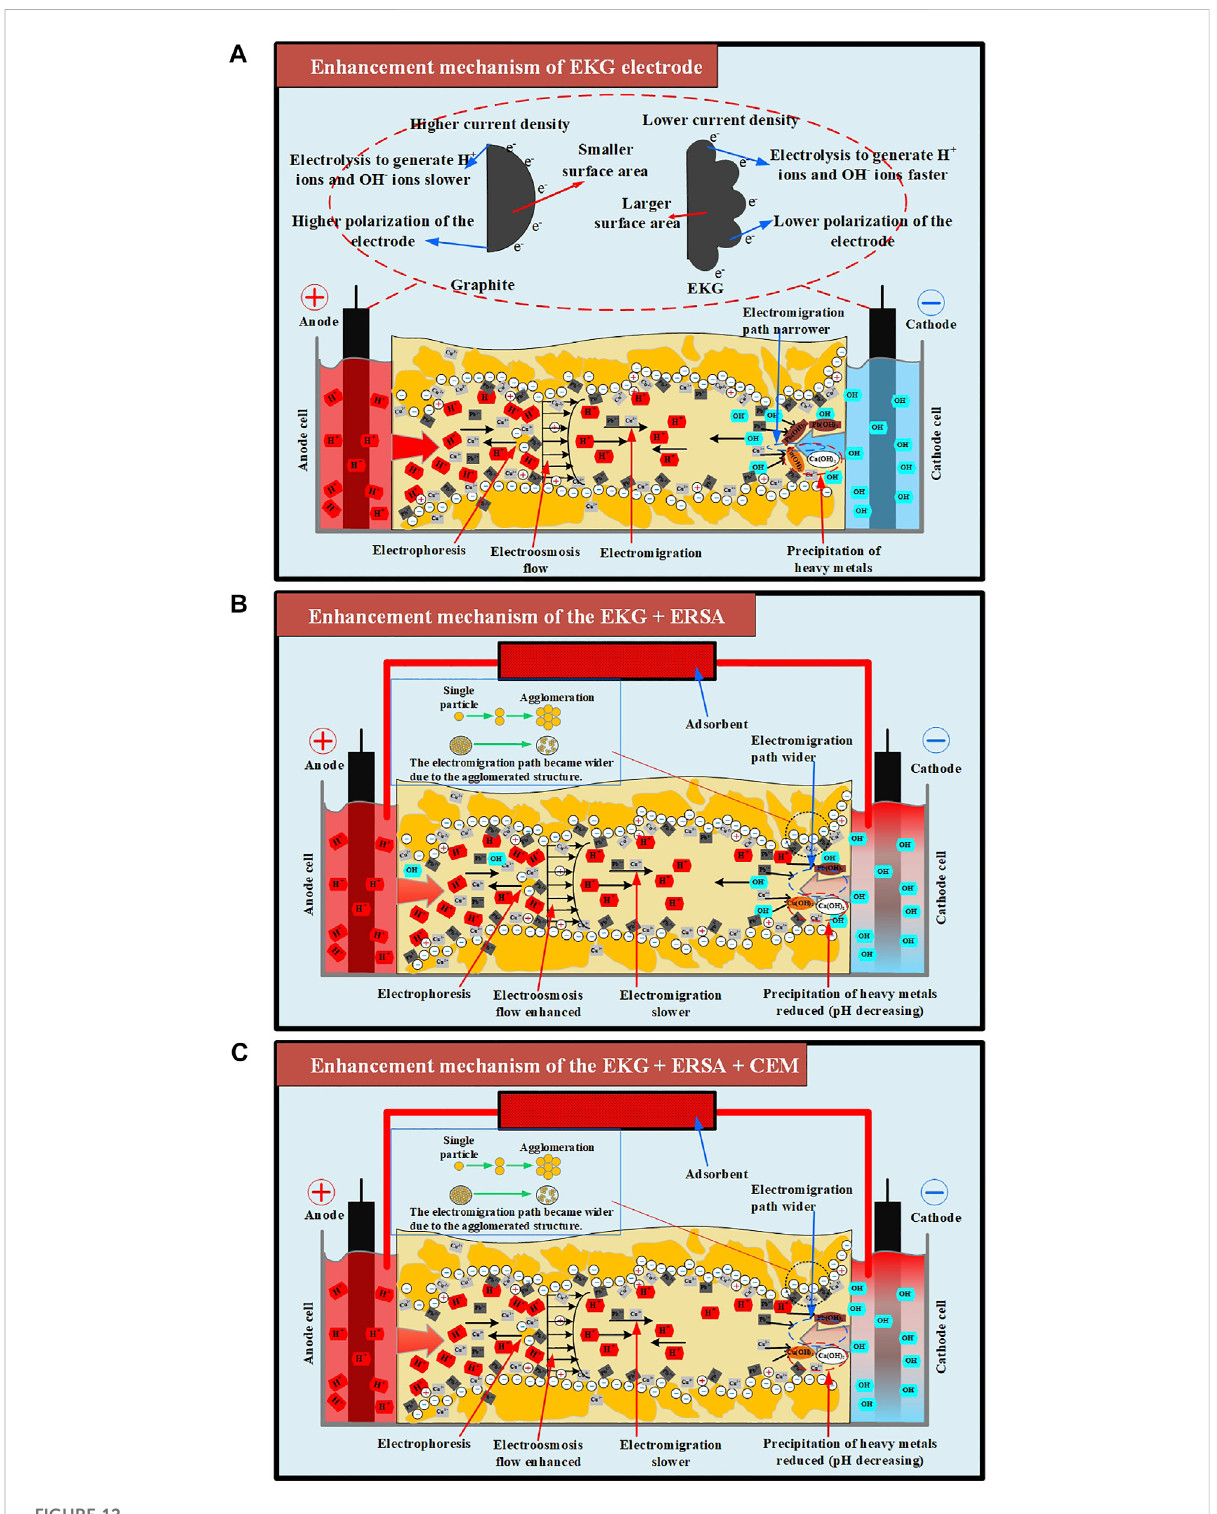
FIGURE 12 The enhancement mechanisms for Cu and Pb removal in loess: (A) enhancement mechanism of EKG electrode, (B) enhancement mechanism of the EKG + ERSA, (C) enhancement mechanism of the EKG + ERSA + CEM.